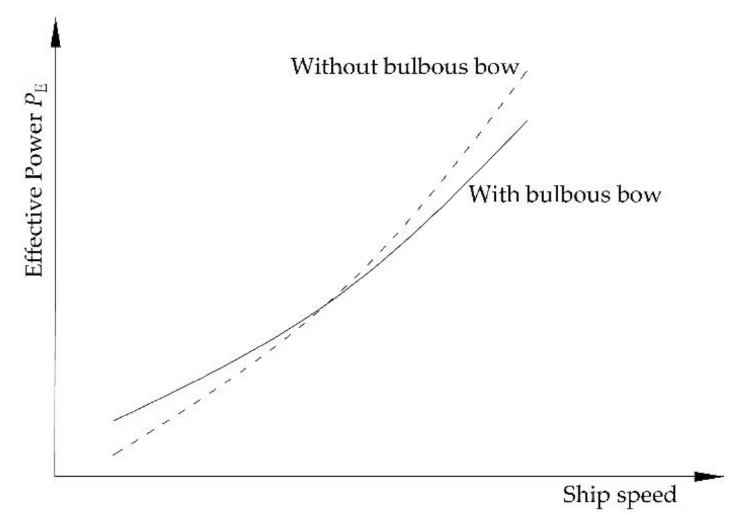
Figure 7. Influence of a bulbous bow on the effective power